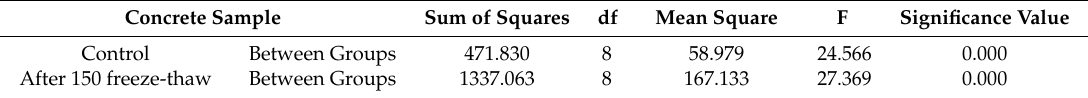
Table 7. ANOVA table for compressive strength of concrete samples after 150 freeze-thaw